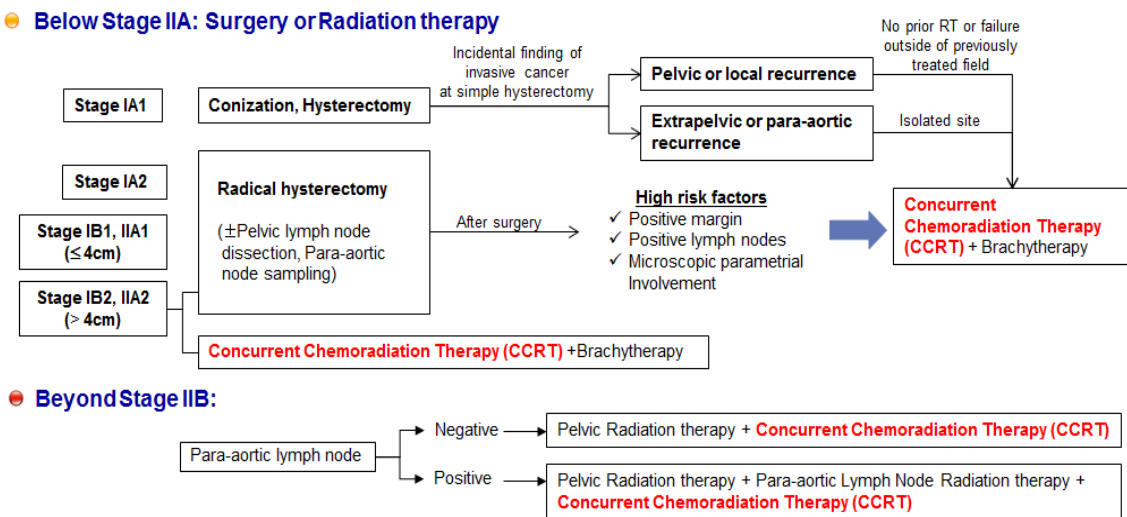
Figure 2. Practice guideline summary for cervical cancer. Concurrent chemoradiation therapy (CCRT) is recommended as the first-line therapy for patients with disease at stage IIB or greater, and as an adjuvant therapy following radical hysterectomy for patients with locally advanced cervical